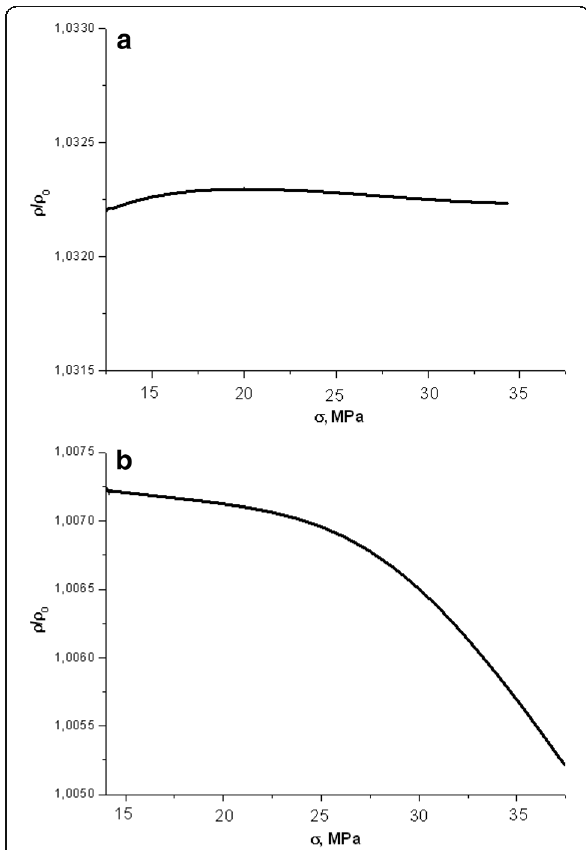
Fig. 3 Dependence of longitudinal resistance of irradiated ( D = 130 Gy) dislocation-free sample of silicon during elastic deformation with a growing strength of compression at a speed of 8 μ m/min ( a ) and 32 μ m/min ( b